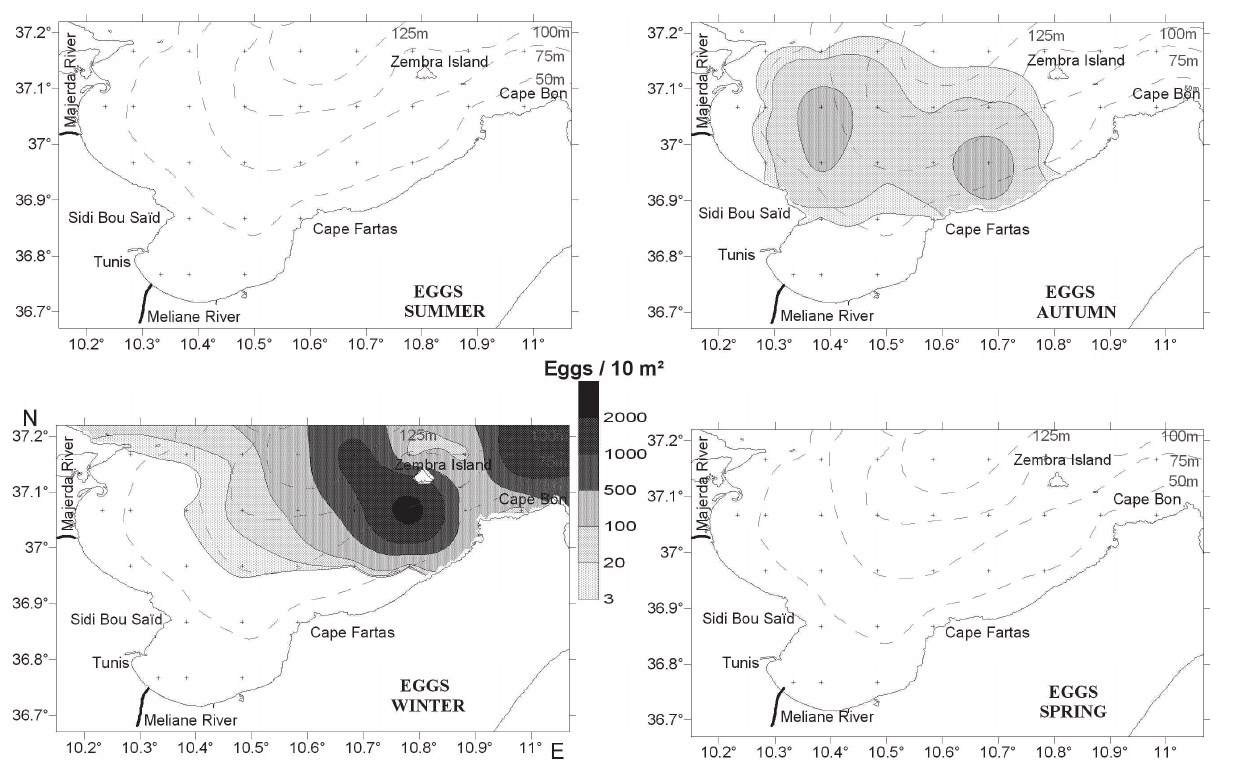
Fig. 8. – Sardina pilchardus egg distribution by